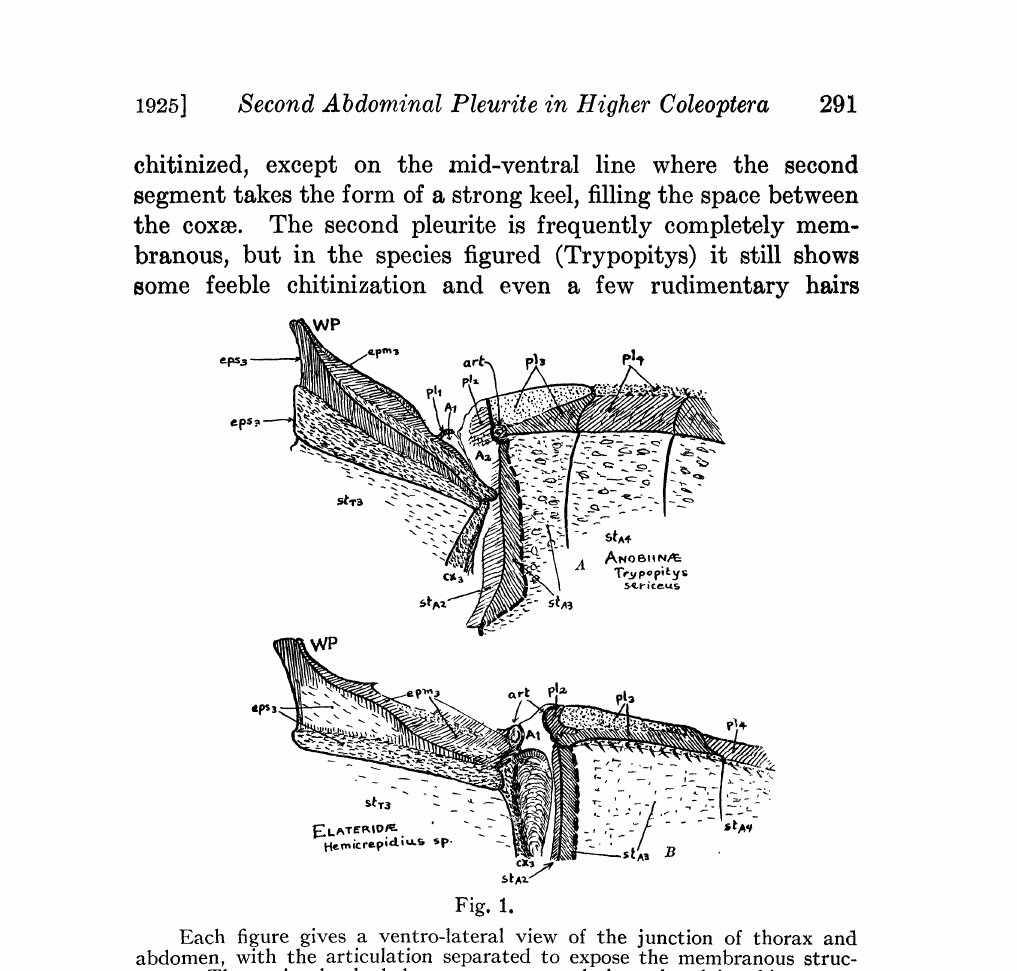
Each figure gives a ventro-lateral view of the unction of thorax and abdomen, with the articulation separated to expose the membranous struc- tures. The variously shaded areas represent scler]tes, the plain white, mem- brane. Hary surfaces indicated, pads for the reception of the elytra stippled, the plain chitn striated. A Membranous first sternal region of